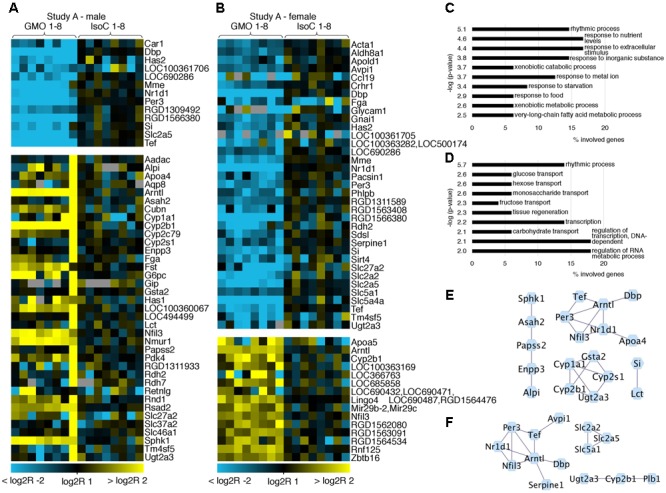
Heatmap of differentially expressed genes and gene ontology (GO) analysis. Heatmaps showing the top 50 differentially expressed genes with more than twofold up- or down-regulation (q < 0.05) in male (A) and female (B) animals of study A. GO analysis of the differentially expressed genes (log2R > 1 or < –1) indicates pathways in which regulated genes show a highly significant enrichment in males (C) or females (D). Networks of protein-protein interactions of males (E) or females (F) using STRING demonstrate associations in sets of differentially expressed genes.